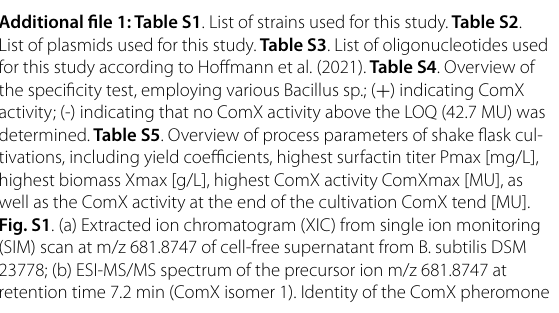
Fig. S1 . (a) Extracted ion chromatogram (XIC) from single ion monitoring (SIM) scan at m/z 681.8747 of cell-free supernatant from B. subtilis DSM 23778; (b) ESI-MS/MS spectrum of the precursor ion m/z 681.8747 at retention time 7.2 min (ComX isomer 1). Identity of the ComX